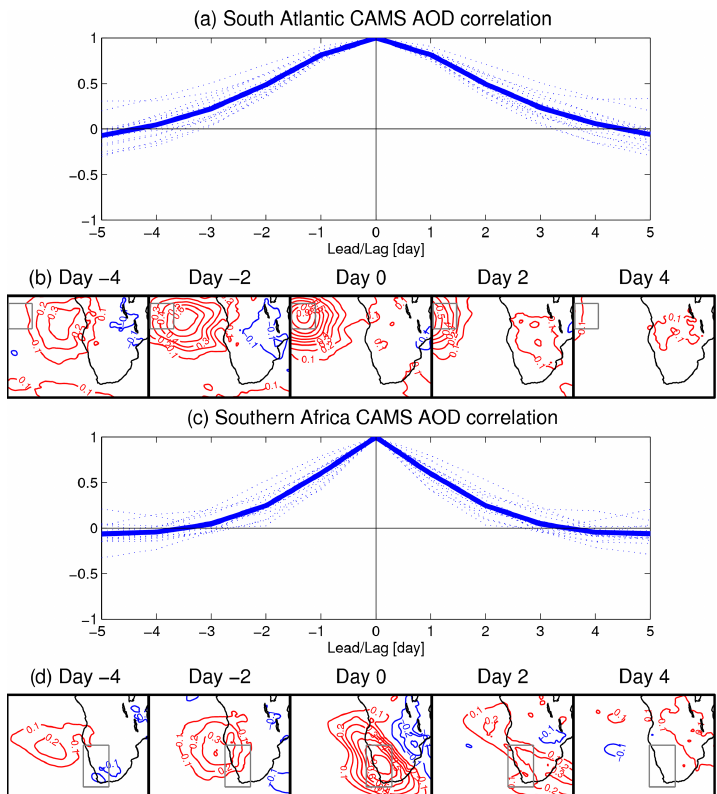
Figure 9. Daily lead–lag correlation analysis of CAMS AOD anomalies. AOD anomalies averaged in the (a) South Atlantic and (c) southern Africa are correlated with themselves: dotted lines display individual year correlations; South Atlantic and southern Africa domains are displayed as boxes in (b) and (d) , respectively. Correlation maps: AOD anomalies averaged in the (b) South Atlantic and (d) southern Africa are correlated with the AOD anomalies in the South Atlantic and southern Africa domain. Correlations are computed year-by-year and